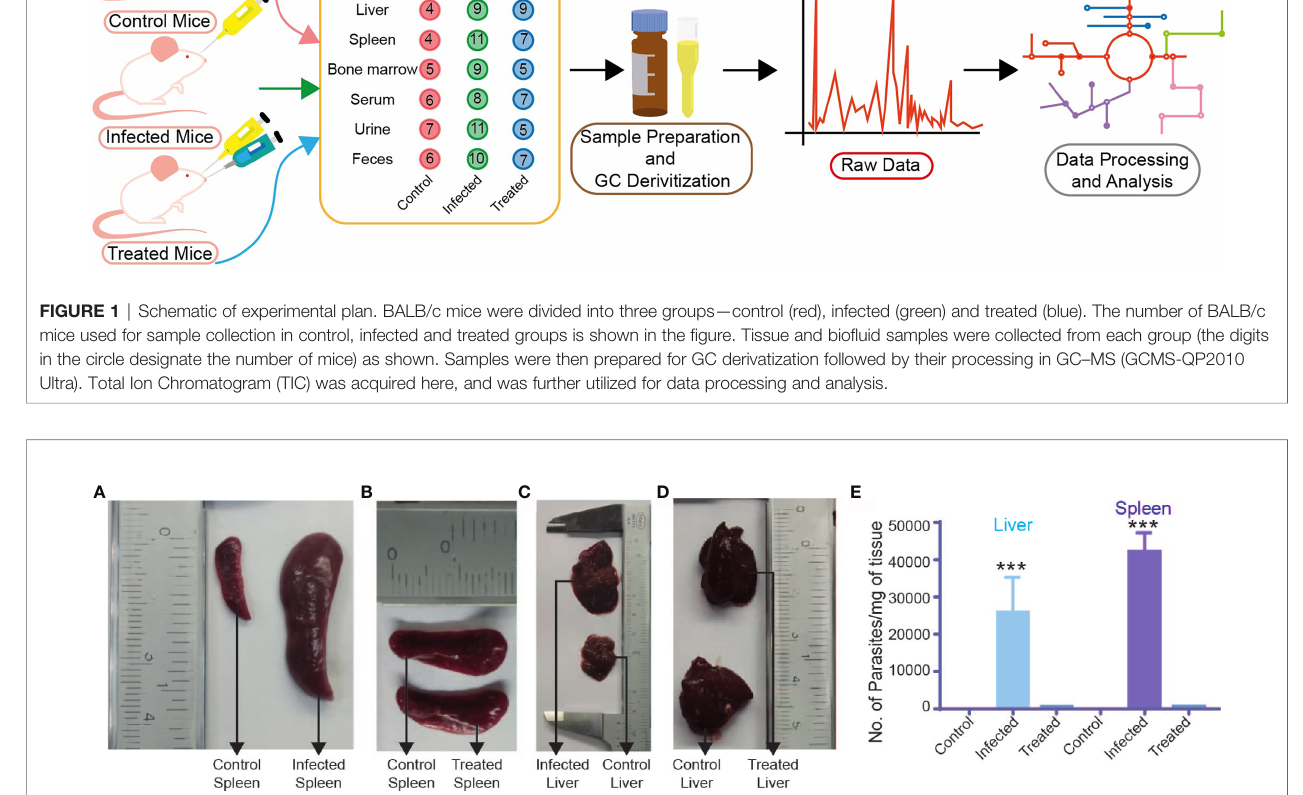
FIGURE 2 | Parasite load determination: Representative images of (A) control and infected spleens showing enlargement in the infected spleen. (B) Control and treated spleens showing normalization of the spleen after treatment with miltefosine. (C) Control and infected liver showing enlargement in the infected liver. (D) Control and treated liver showing normalization of the liver after treatment. (E) Parasitic load determination in control, infected and treated liver and spleen samples using RT-PCR. ***p ≤ 0.001.